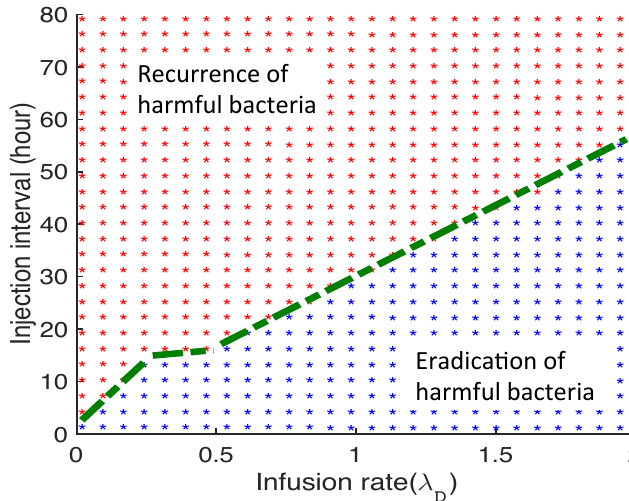
Figure 14. Therapeutic strategies of eradicating harmful bacteria by the injection of immune-boosting drugs for various infusion rates ( λ D ) and injection periods ( τ D ) in a two-species M2 model (52)–(56). Eradication (blue asterisk) and recurrence (red asterisk) of harmful bacteria in the λ D - τ D parameter space ( t d = 1.0 fixed) at t = 300. Initial condition: B 1 ( 0 ) = 0.2, B 2 ( 0 ) = 0.95, A E ( 0 ) = 0.0, D ( 0 ) = 0. Parameter values: N D = 60, δ D = 0.1, τ 1 = τ 2 = 3.5; all other parameters are fixed as in Table